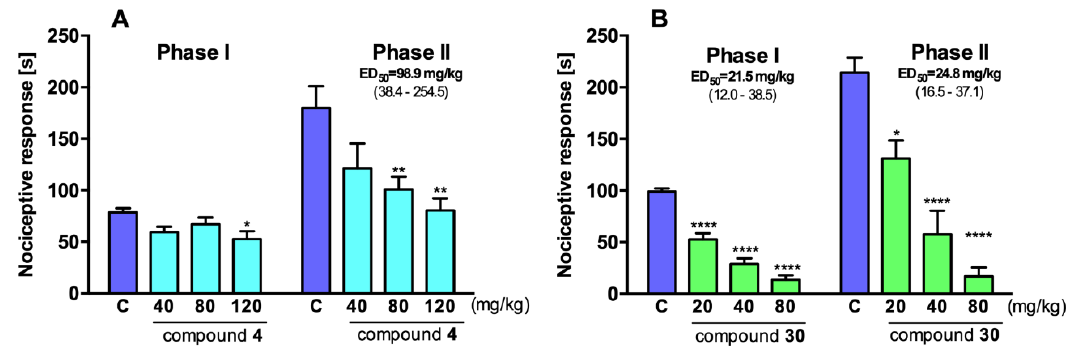
Figure 2. Antinociceptive activity of compounds 4 ( A ) and 30 ( B ) in the formalin test. Results are shown as time of licking in phase I (0–5 min after intraplantar injection of formalin) and in phase II (15–30 min after formalin injection). Each value represents the mean ± standard error of the mean (SEM) for 8–10 animals. Statistical analysis: one-way ANOVA followed by post hoc Dunnett’s test. Statistical significance compared to vehicle-treated animals (Tween): * p < 0.05, ** p < 0.01, **** p < 0.0001. C—control group.